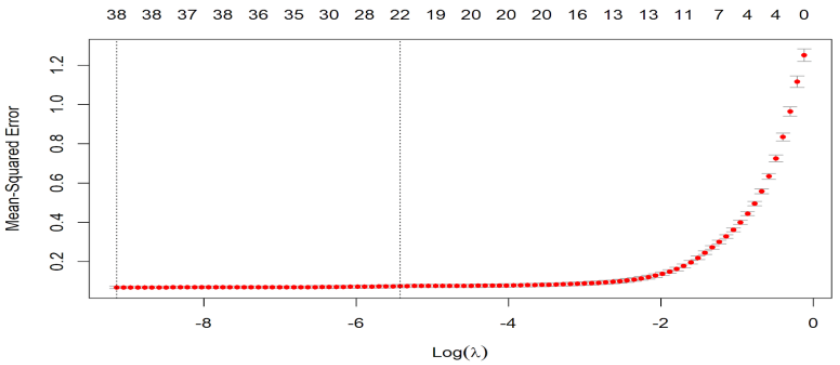
Figure 4. MSE of LASSO model. Showing how the number of features selected is affected by the MSE value.